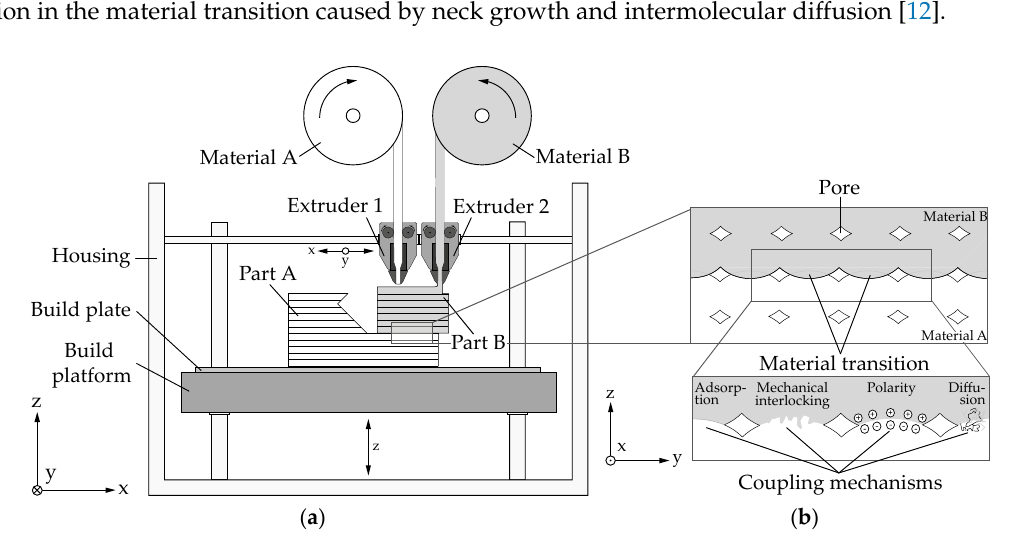
Figure 2. Overview of different load types.